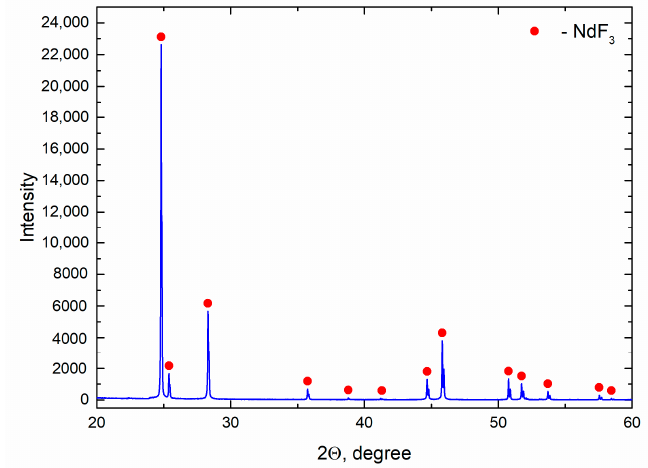
Figure 3. The X-ray diffraction pattern of prepared NdF 3.